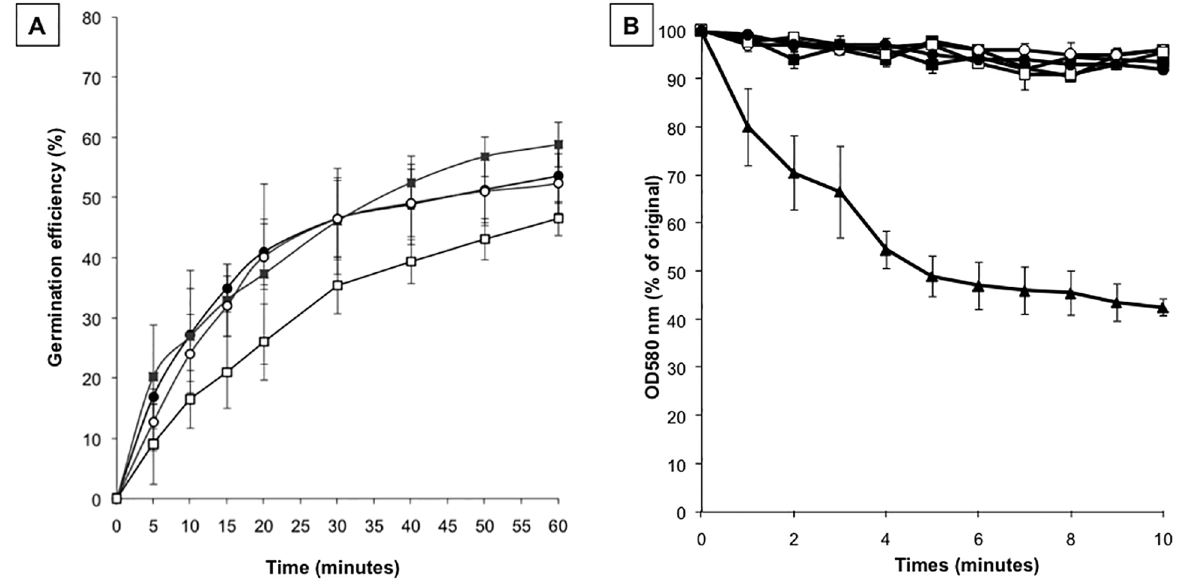
Figure 3. Germination efficiency and lysozyme-resistance assays. Spores derived from wild type (PY79, black circles), cotG null (AZ604, white circles), cotH null (ER220, white squares) and cotGcotH null (AZ603, black squares) were tested for germination efficiency (A) and for lysozime resistance (B). Germination was induced by Asn-GFK and measured as percentage of loss of optical density at 580 nm. Similar results were obtained by using L-Ala to induce germination. A cotE null strain (black triangles) known to be sensitive to lysozyme has been used as positive control during the lysozime treatment. Error bars are based on the standard deviation of 4 independent experiments.